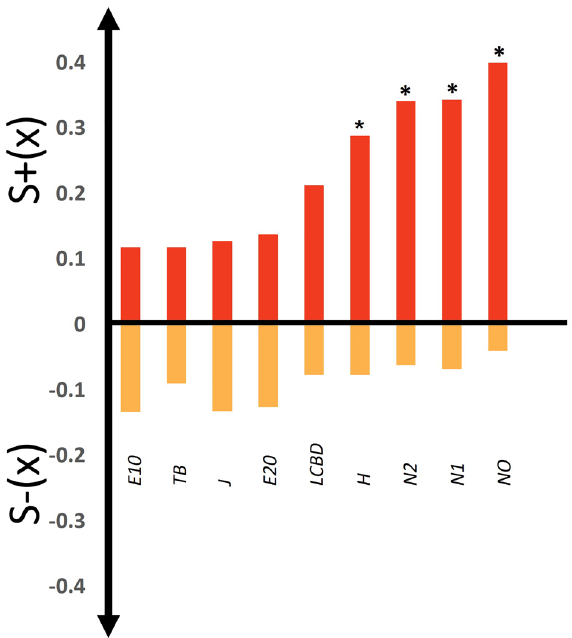
Figure 1. Levels of positive and negative spatial autocorrelation for the plant community parameters. Asterisks indicate significant autocorrelation ( P < 0.05). N0 : Richness; H : Shannon entropy; N1 : Shannon diversity; N2 : Simpson diversity; E10 : Shannon evenness; E20 : Simpson evenness; J : Pielou’s evenness, TB: Total biomass and LCBD: Local Contribution to